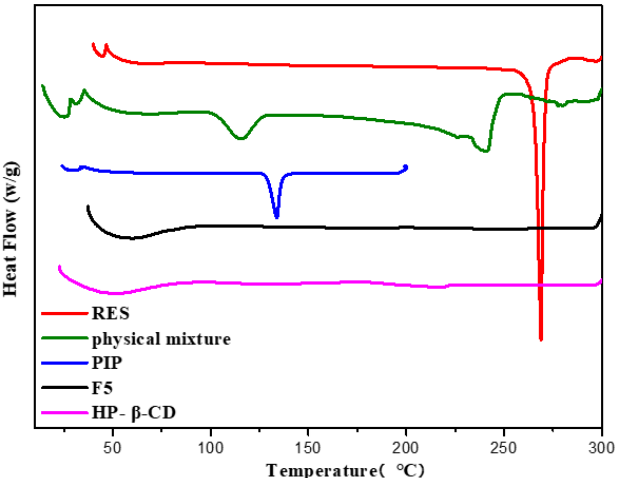
Figure 6. DSC profiles of RES, PIP, HP- β -CD, physical mixture, and representative spray-dried microcapsules (F5).